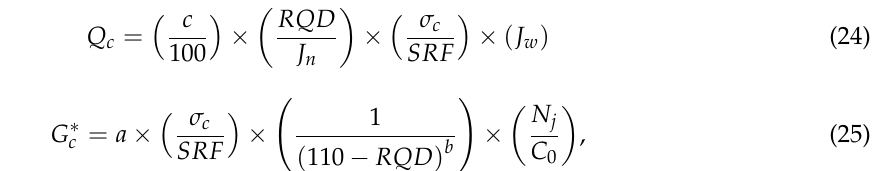
Table 7. Constants a , b , and c for equations (24) and (25) based on Table 4. Case No.